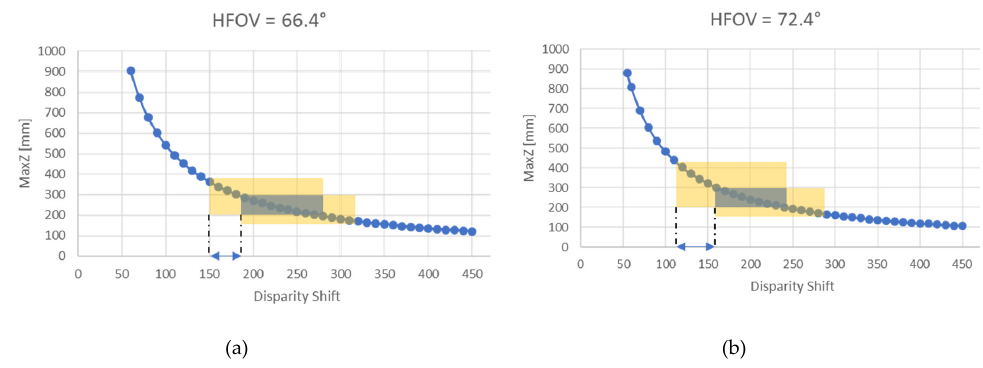
Figure 6. The graph shows the maximum acquirable depth as a function of the disparity shift, calculated considering HFOV = 69.4° ± 3°. The blue rectangle indicates the depth range 200–300 mm. calculated considering HFOV = 69.4 ◦ ± 3 ◦ . The blue rectangle indicates the depth range 200–300 mm. The yellow rectangles are obtained computing the first and the last values of disparity shift that allow HFOV = 72.4°. HFOV = 72.4 ◦ .